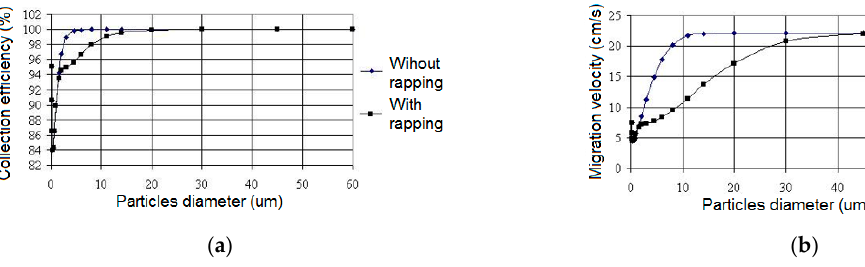
Figure 11. ( a ) The collection efficiency depends on the diameter of the dust particles. ( b ) The migration velocity depends on the diameter of the dust particles, without and with rapping, and the thickness of the 5 mm dust layer.